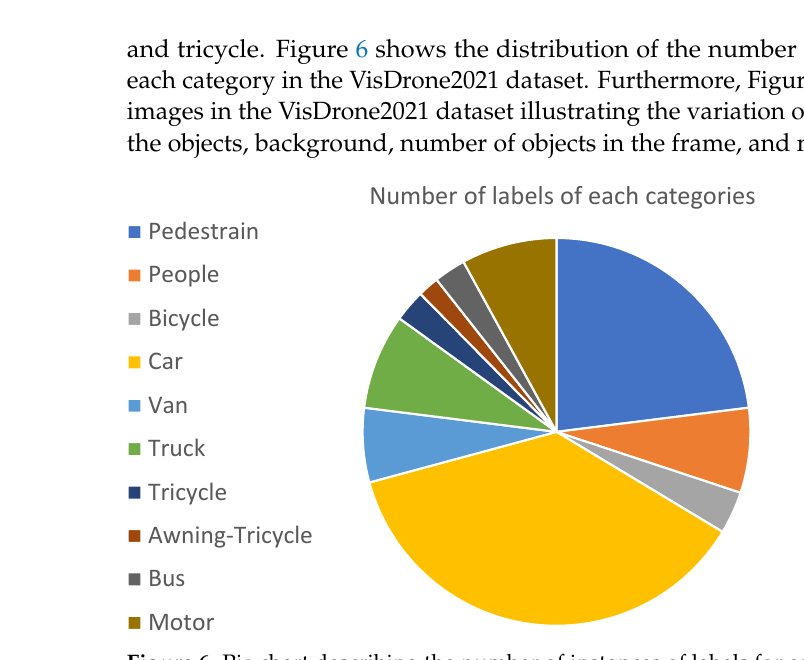
Figure 6. Pie chart describing the number of instances of labels for each category.